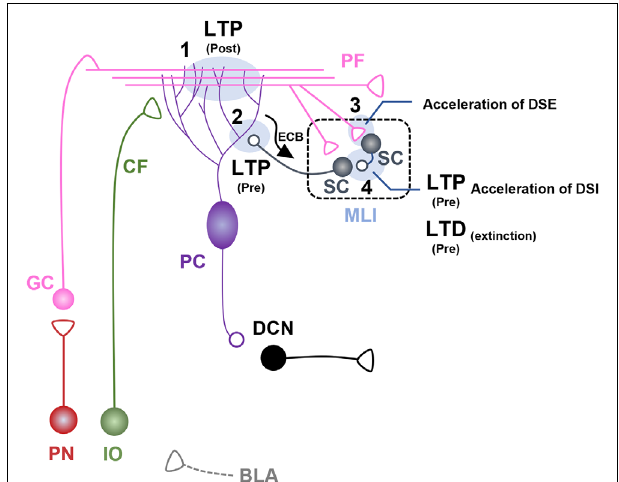
FIGURE 2 | Fear learning-induced changes in cerebellar lobule V-VI microcircuits. Schematic illustration of cerebellar microcircuits regulating conditioned stimulus (CS)-dependent fear learning and memory in lobules V-VI. Each synaptic site is labeled with a number. (1) Postsynaptic long-term potentiation (LTP) occurs at parallel fiber (PF)-pyramidal cell (PC) synapses after auditory fear conditioning, underpinned by basolateral amygdala (BLA) activity during fear learning (Sacchetti et al., 2004; Zhu et al., 2011). (2) Presynaptic LTP occurs at molecular layer interneuron (MLI)-PC synapses after auditory fear conditioning (Scelfo et al., 2008; Dubois et al., 2020). PC-driven regulation of endocannabinoid signaling at MLI-PC synapses is involved in fear learning and memory (Dubois et al., 2020). (3) Auditory fear conditioning induces acceleration of depolarization-induced suppression of excitation (DSE) at PF-stellate cell (SC) synapses. (4) Auditory fear conditioning induces presynaptic LTP and accelerated depolarization-induced suppression of inhibition (DSI) at SC-SC synapses. Fear extinction learning induces presynaptic long-term depression (LTD) at SC-SC synapses (Dubois and Liu,